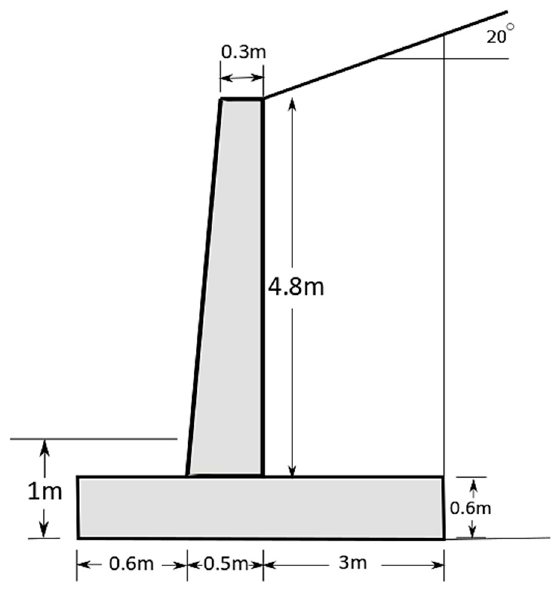
Figure 1. Considered retaining wall .